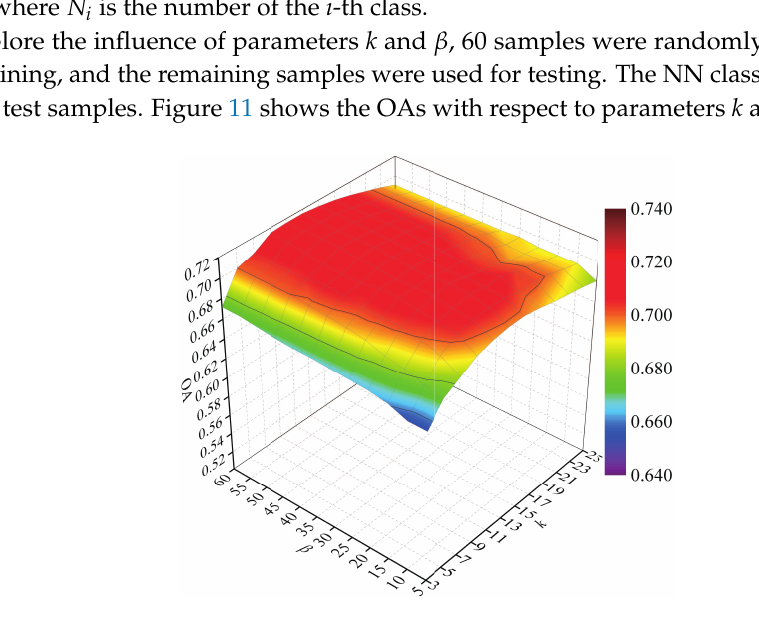
Figure 11. OAs with respect to different numbers of neighbors on the Indian Pines data set.